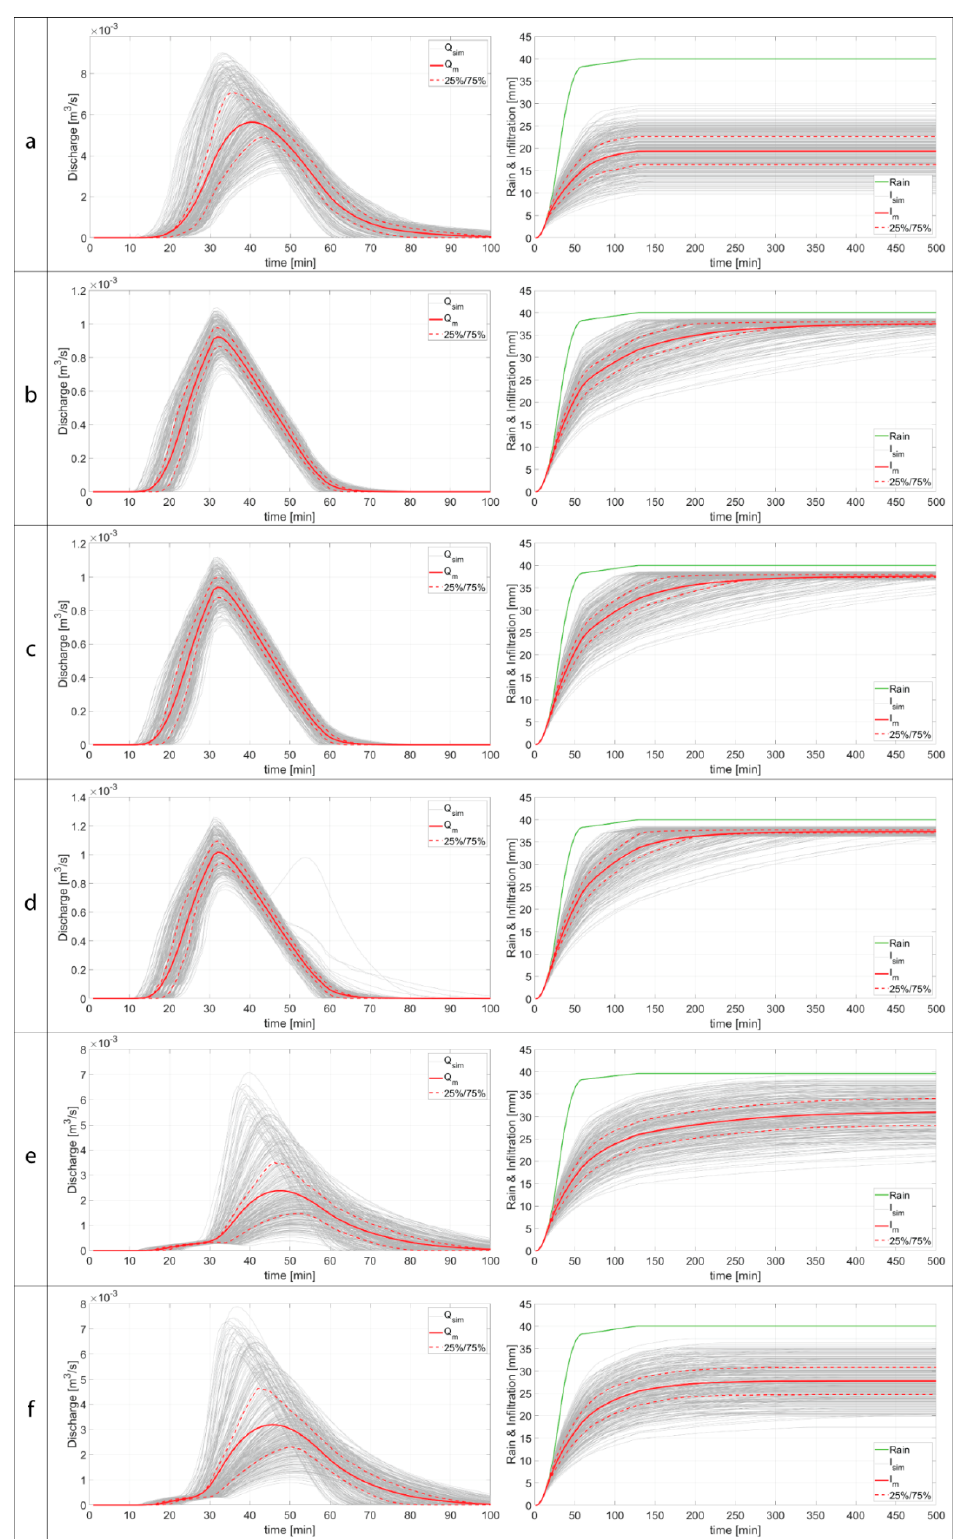
Figure A2. Hydrographs and infiltration trends computed for the Monte Carlo simulations in the PL (row a ), HM 30 (row b ), HM 20 (row c ), HM 10 (row d ), PP 20 (row e ), and PP 10 (row f ) configurations. Red solid lines are the mean discharge and mean infiltration, respectively. Red dashed lines represent the first and third quartile of the distribution. Light gray solid lines are the outcomes of each simulation.